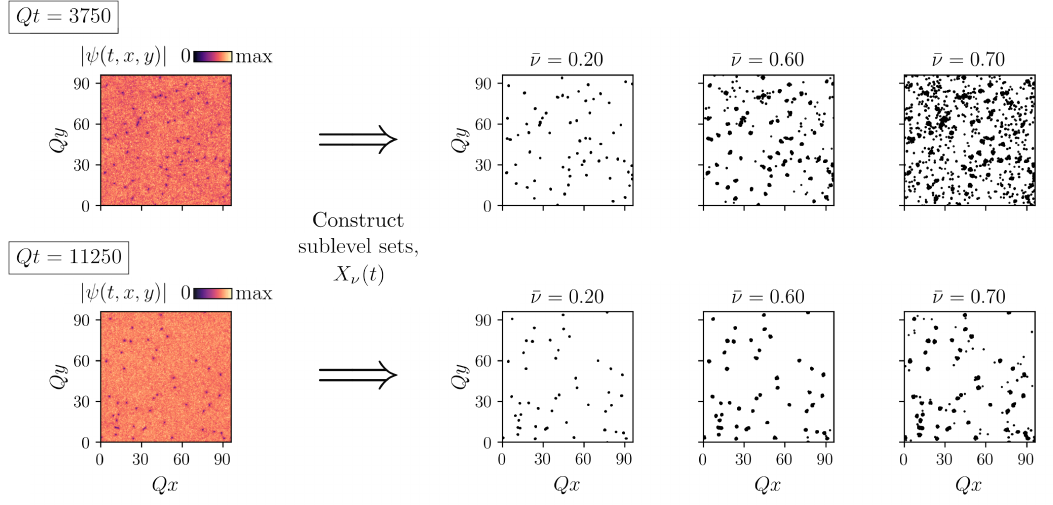
Figure 3: Amplitudes of an example field configuration and corresponding point clouds. First column from the left: Spatially-resolved field amplitudes, | ψ ( t , x , y ) | . Second to fourth column: Point clouds X ν ( t ) for the different ¯ ν -values indicated. First row: Qt = 3750. Second row: Qt =